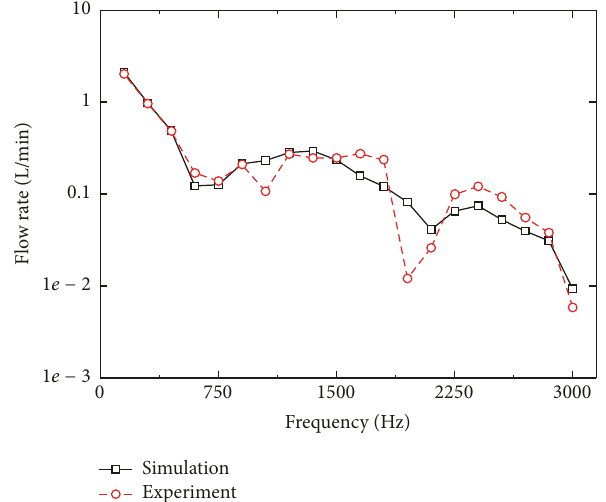
Figure 5: Comparisons of the simulated and measured flow ripples in frequency